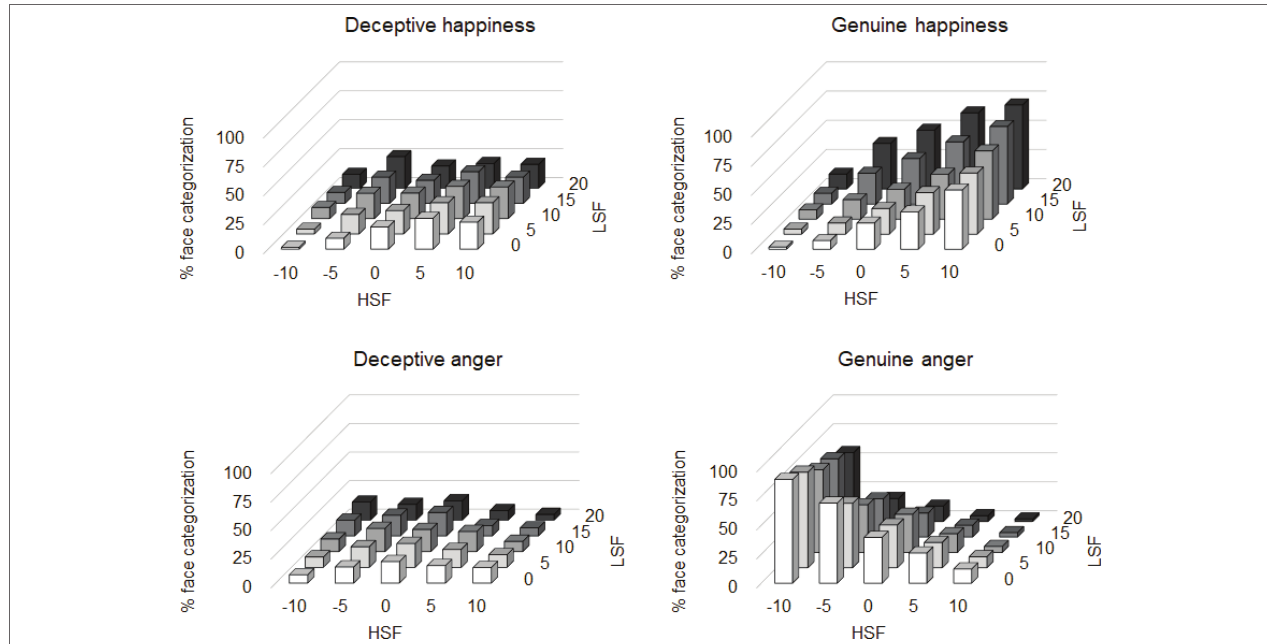
FIGURE 3 | Results of Experiment 2. Mean percentage of classification as the deceptive happiness (top-left panel), the genuine happiness (top-right panel), deceptive anger (bottom-left panel), and genuine anger (bottom-right